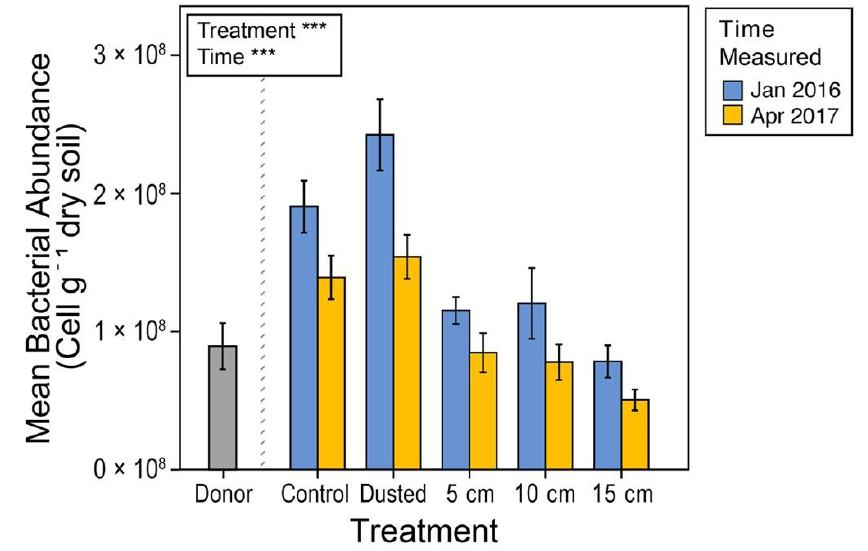
Figure 7. Bacterial abundance by treatment. “Donor” refers to bacterial abundance levels found at the donor site, while all other treatment conditions refer to the recipient sites. Bars represent +/ − 1SE of the mean. Bacterial abundance was measured in January 2016 and in April 2017, and was significantly higher in control and dusted treatments in both 2016 and 2017, with dusted plots containing higher abundance than even the control plots on 2016. (ANOVA, F 5,76 = 19.37, p < 0.0001).